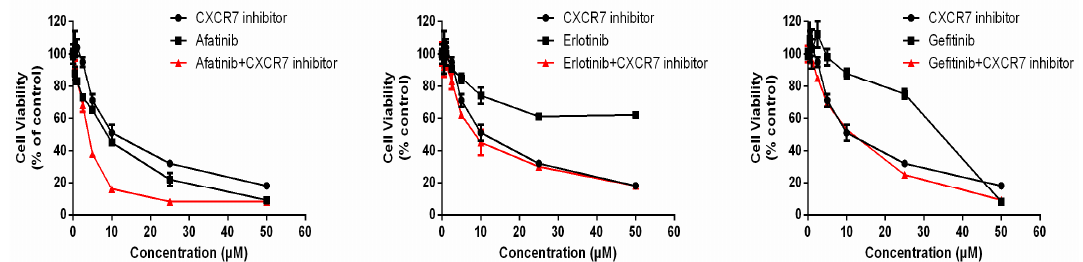
Figure 4. Dual inhibition of CXCR7 and EGFR. Combination of afatinib and CXCR7 inhibitor induces a synergistic inhibitory effect in A549 cell line. Cells were treated with drugs at indicated concentrations for 72 h, and cell viability was determined with an MTS assay. Table 1. Effect of concomitant combination of EGFR-TKI (TKI: tyrosine kinase inhibitor) and CXCR7 inhibitor on A549 cells based on the Chou and Talalay method.